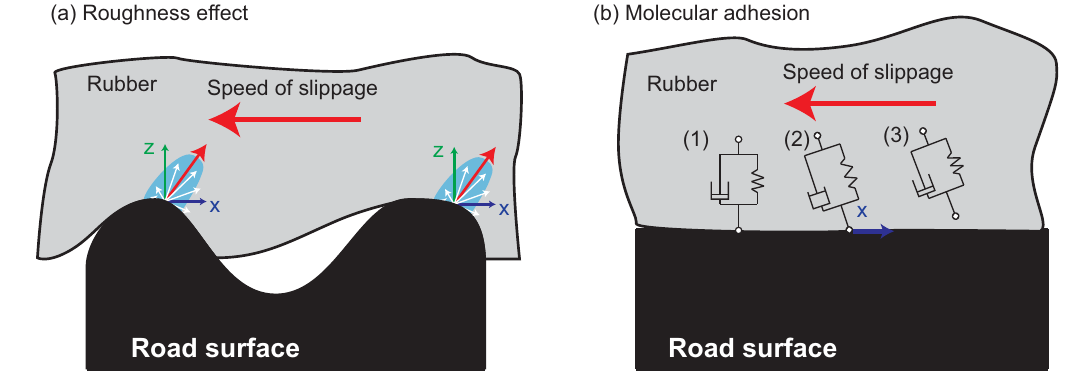
Figure 5. ( a ) Road roughness (indentation) friction mechanism; ( b ) Molecular adhesion friction